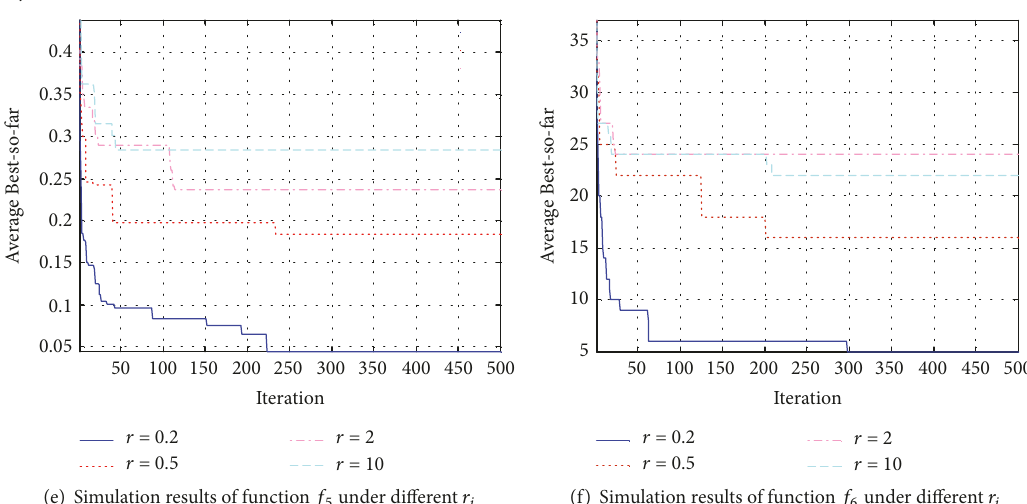
(b) Simulation results of function 𝑓 2 under different 𝑟 𝑖